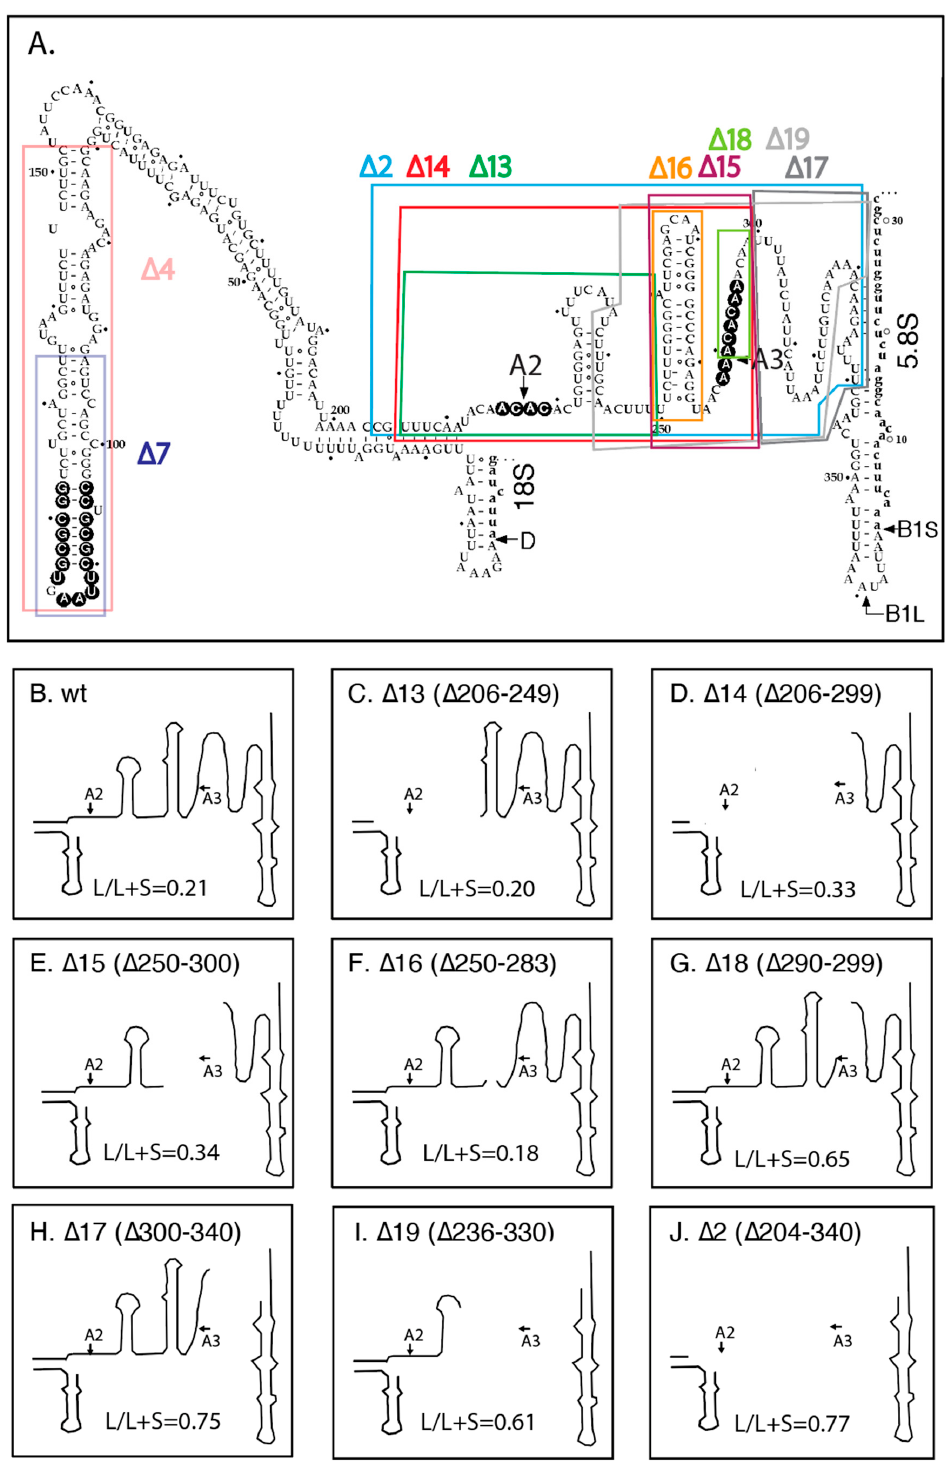
Figure 2. Deletion mutations in ITS1. ( A ) Secondary structure of ITS1 in S. cerevisiae proposed by van Nues at al. [38]. Deletions are shown by color-coded frames around the deleted nucleotides. Phylogenetically conserved nucleotides among a set of Saccharomycetales are shown in reverse contrast; for specifics see [36]. ( B – J ) Schematics of the ITS1 secondary structure in which the deleted parts in each mutant are blocked out. The total 5.8S rRNA constituted by 5.8S L (“L-fraction”) was determined from northern blots loaded with RNA extracted from cells carrying each of the deletion plasmids. The numbers are the average of the measurements from 25 ◦ and 37 ◦ in ∆ rpa12 ∆ xrn1 and YLL53 ( RRP2 ); the latter strain is not deleted for XRN1